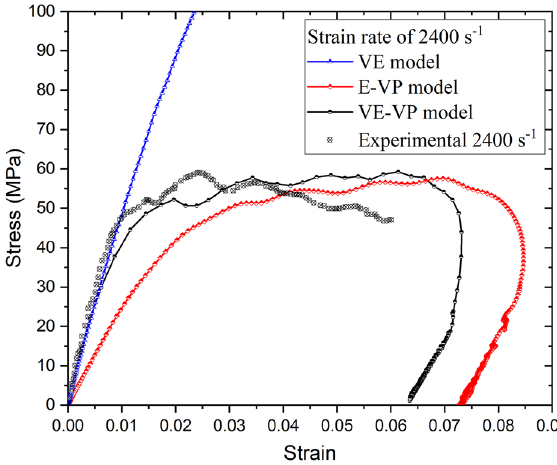
Figure 7. Comparison of the VE, EVP, and VE–VP models.